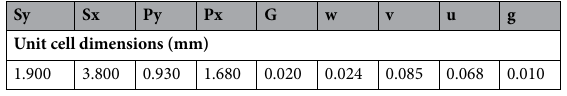
Table 1. Unit cell dimensions.